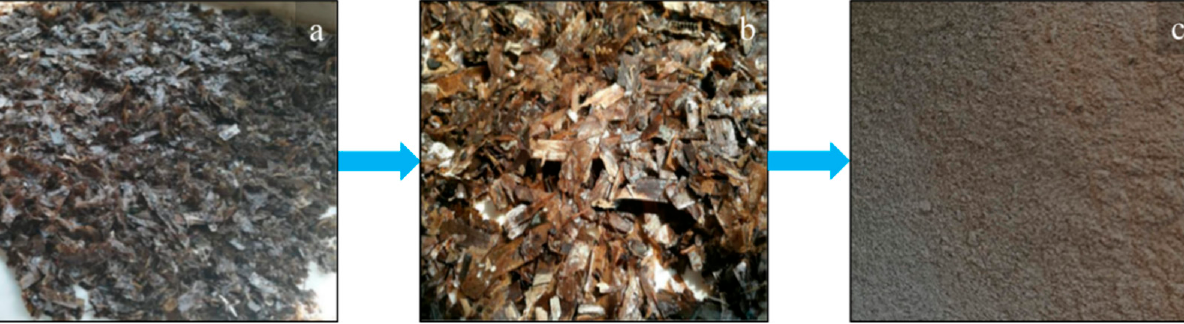
Figure 2. Raw POL before ( a ) and after ( b ) washing and after chopping ( c ).